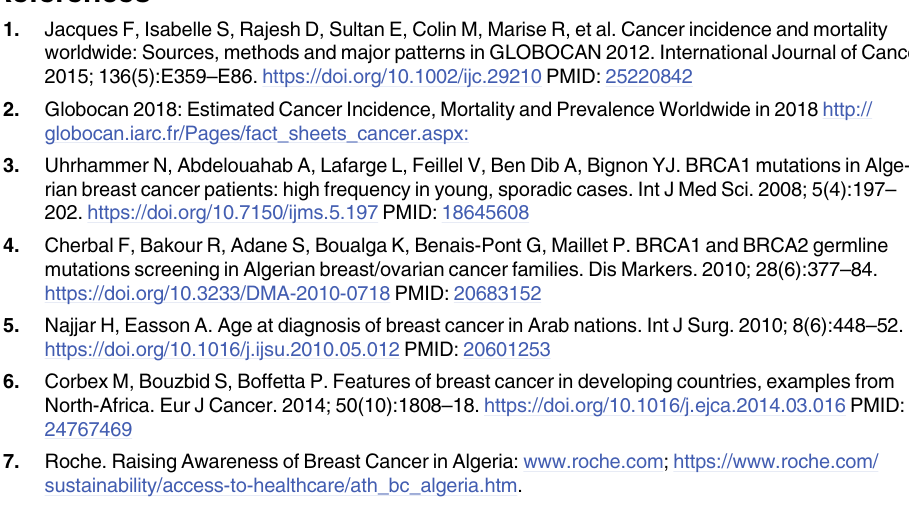
S1 Fig. GO Biological Processes of validated targets for miR-182 (A),183 (B), 21 (C), 200c (D), 125b (E), and 100 (F). Validated targets were identified using PubMed literature search and their GO Biological Processes were determined using Enrich software